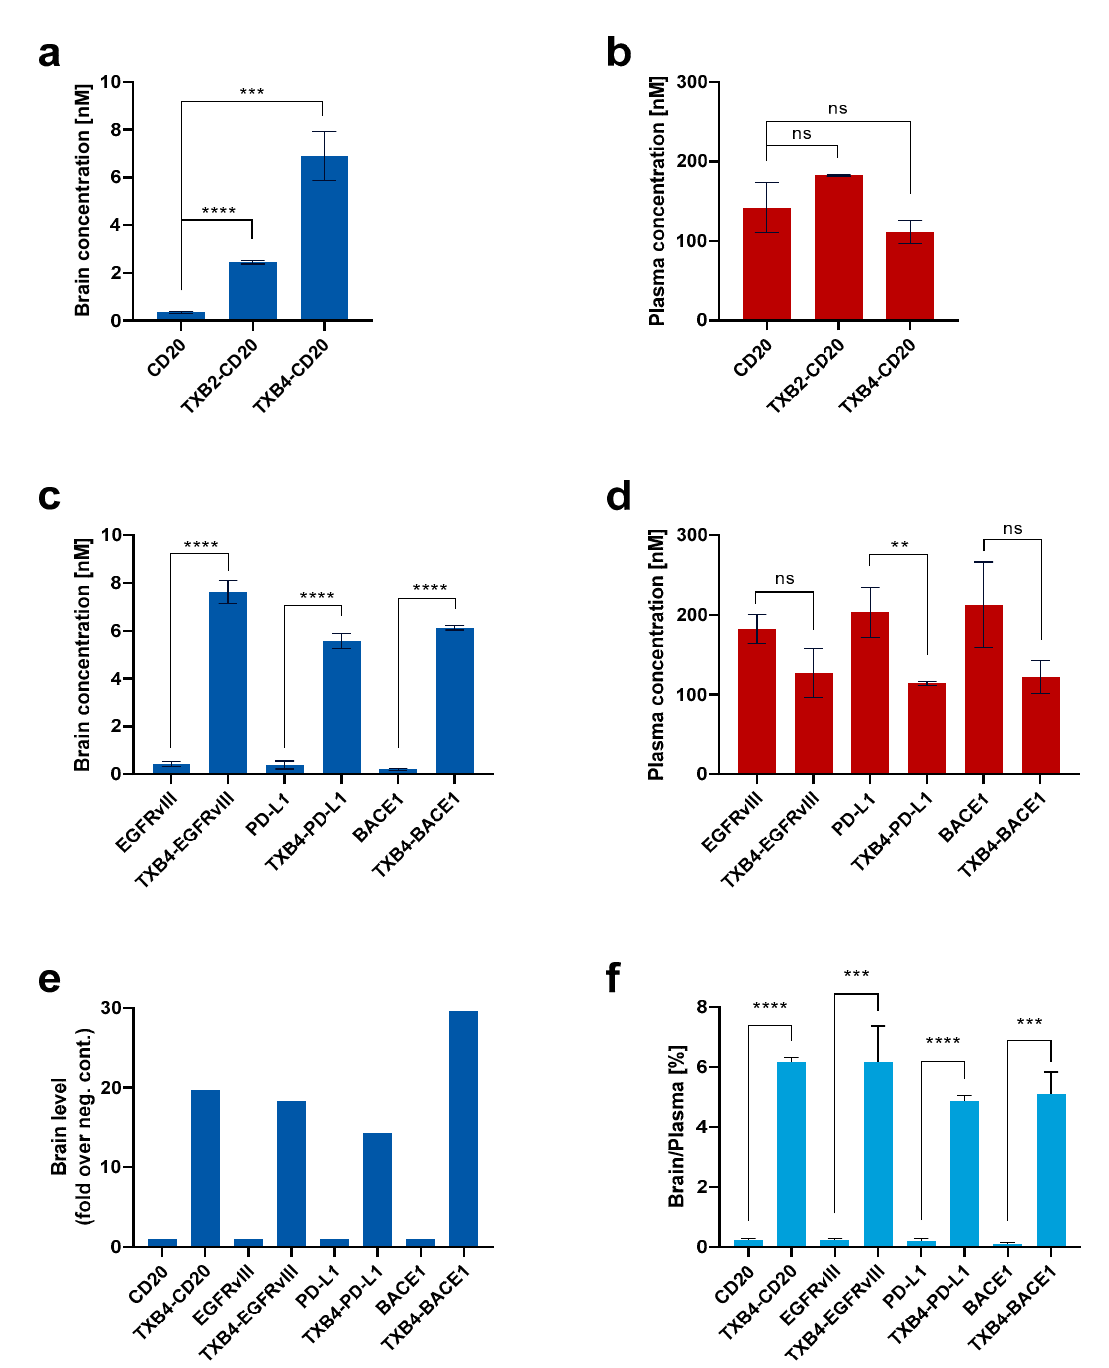
Figure 5. TXB4 is highly efficient in therapeutic antibody delivery to the brain. Antibody to CD20 alone, TXB2-CD20 and TXB4-CD20 fusions were dosed in mice at 25 nmol/kg. At 18 h post injection ( a ) brains and ( b ) plasma were collected and analyzed by ELISA (mean ± SD, n = 3). Therapeutic antibodies to EGFRvIII, PD-L1 and BACE1 as unmodified or as TXB4 fusions were dosed in mice at 25 nmol/kg with ( c ) brains and ( d ) plasma collections performed at the 18 h timepoint post injection followed by ELISA analysis (mean ± SD, n = 3). ( e ) Brain penetration data for therapeutic antibodies (compiled from Figure 5a,c) presented as average fold over corresponding unmodified antibody (fold increase over control). ( f ) Percentage brain/plasma ratio data for therapeutic antibodies (compiled from Figure 5a–d) (mean ± SD, n = 3). Significance at ** p < 0.01, *** p < 0.005, **** p < 0.0001 using two-tailed, unpaired t -test, and ns indicates not significant difference.